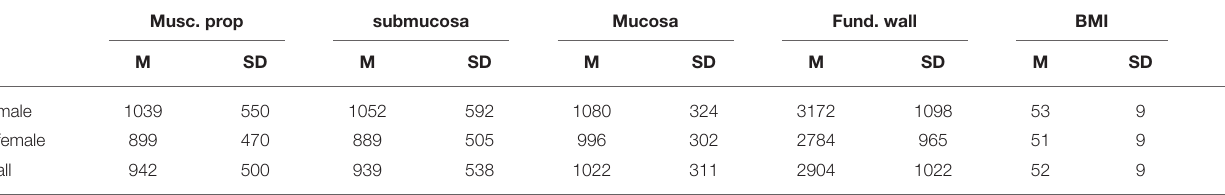
TABLE 2 | Descriptive data of mean fundus-wall thickness, BMI, and gender.